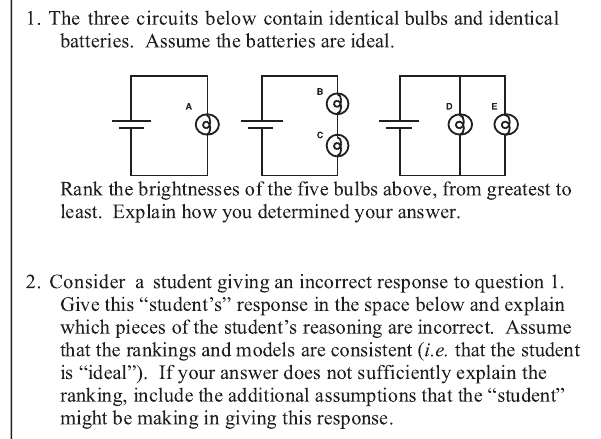
1. ‘‘Five-bulbs’’ question (1) [32] and extension to assess knowledge of student ideas (KSI) (2). Correct response (for ideal batteries and bulbs): A ¼ D ¼ E > B ¼ C . Common incorrect responses (meaning, ‘‘correct KSI responses’’) include A > B ¼ D ¼ E > C for current-used-up explanations and A > B ¼ C ¼ D ¼ E for fixed-current, current-sharing